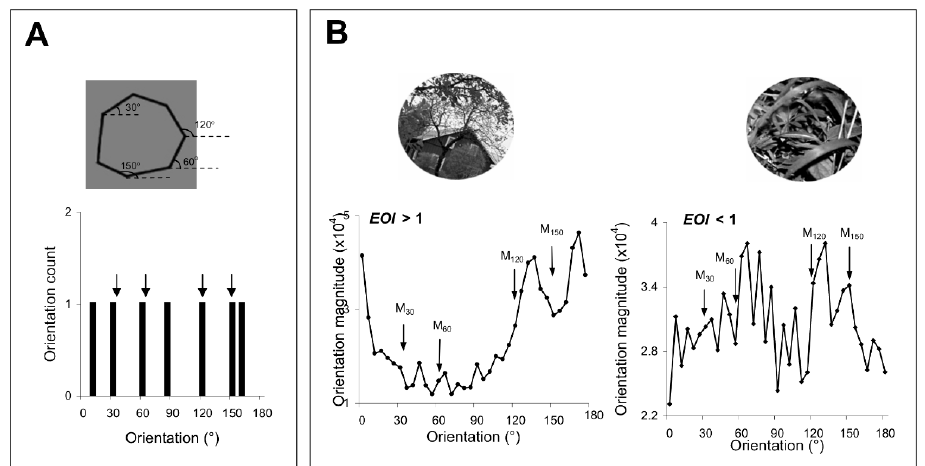
Figure 2. ( A ) Shape discrimination. We generated polygons with four of the sides oriented along the exposed axes, i.e., 30°, 60°, 120°, and 150°. The histogram below indicates the orientation distribution of the corresponding shape, with arrows pointing toward the orientations presented during the exposure stage. ( B ) Image discrimination. Two representative images and their corresponding exposure orientation index, EOI, which quantifies the relative strength of the orientation signals along exposed axes in each image. For each image, we determined the orientation at each pixel location based on the direction of the local gray-scale gradient in a standard 25-pixel array from the arc tangent of the partial derivative of brightness in a 5 × 5 kernel in the vertical direction, divided by this value in the horizontal direction [13]. The results for all the pixels are represented as orientation magnitude histograms (below each image). Arrows point toward the orientations presented during